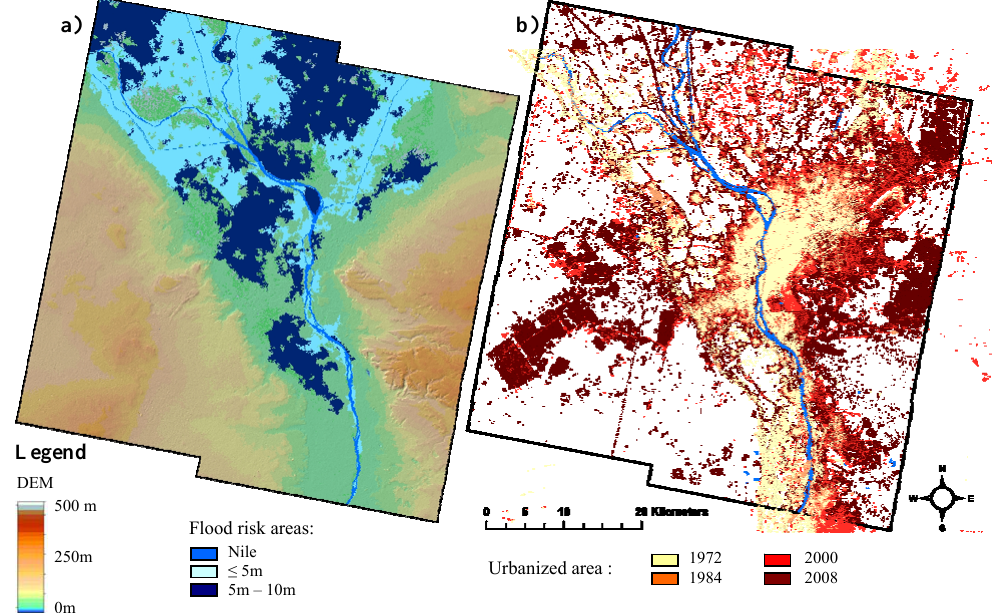
Fig. 2. (a) Scenario-based assessment of flood prone areas at mega city Cairo (b) Urbanization on urban footprint level from 1972 until 2008